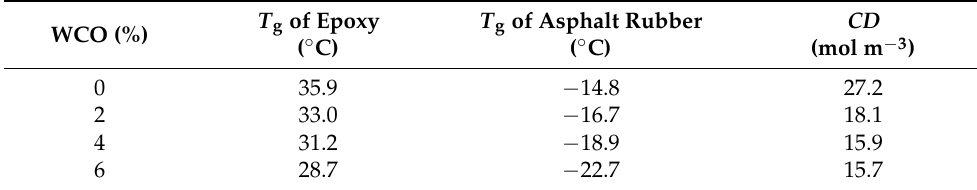
Table 2. Glass transition temperatures and crosslink densities of the unmodified and WCO-modi- fied EAR binders.